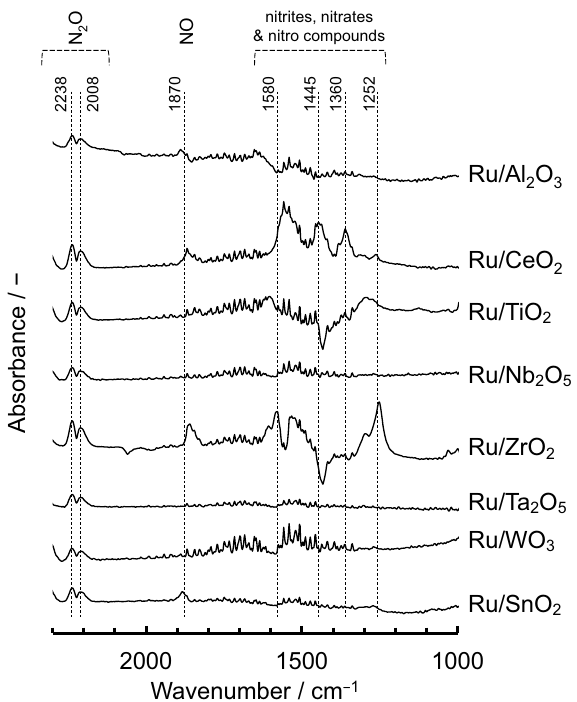
Figure 3. In situ FTIR spectra of N 2 O adsorbed on 5.0 wt% Ru supported on various different metal oxide materials, measured at 200 °C in gas feeds of 200 ppm of N 2 O and N 2